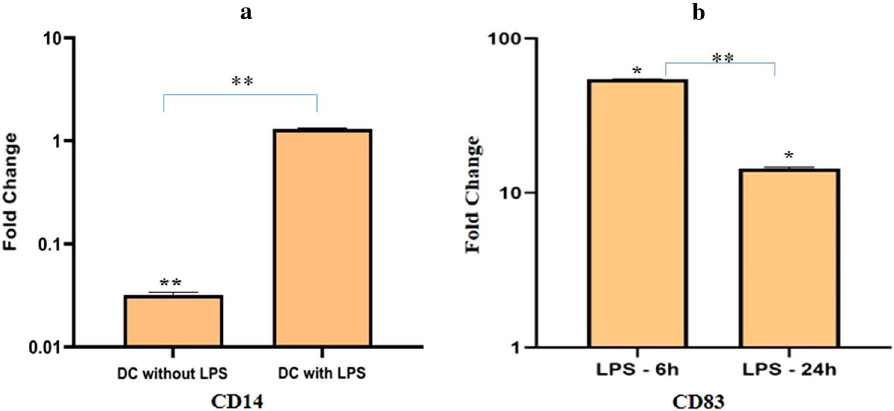
Figure 2. Fold change expression of cell surface molecules (CD14 and CD83) on chMoDCs 0 h and 24 h after exposure to Salmonella LPS (1 µg/mL). The mRNA expression for CD14 and CD83 was determined by real time-quantitative polymerase chain reaction (RT-qPCR); ( a ) data were analysed by Tukey’s multiple comparisons test to detect differences in mRNA expression of CD14 on immature and mature chMoDCs in relation to PBMCs. Values shown are mean ± SEM of three independent experiments ( **P < 0.0001); ( b ) the fold- change expression of CD83 on chMoDCs at 6 h and 24 h post-LPS treatment in relation to immature DCs. Data were analysed by t -test. Values shown are mean ± SEM of three independent experiments ( **P < 0.0001).